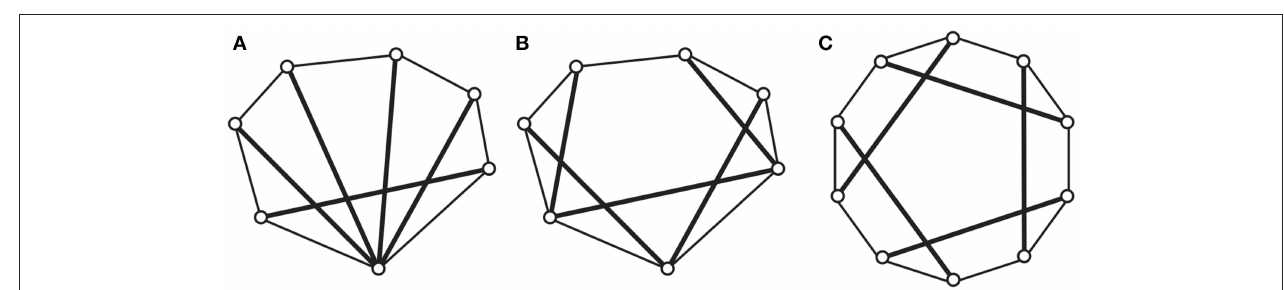
FIGURE 10 | Polygons satisfying Theorem 6: (A) a Grünbaum polygon; (B) a Cauchy polygon; (C) a Snelson polygon. Thin and thick lines corresponds respectively to cables and struts.